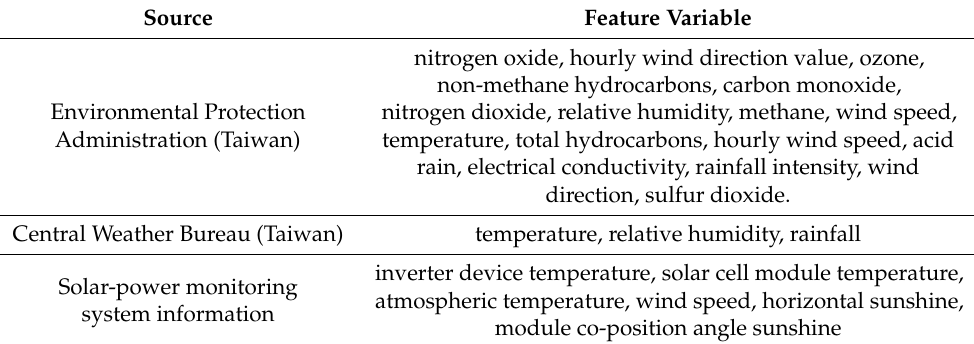
Table 3. List of feature variables of data set used after Pearson correlation coefficient